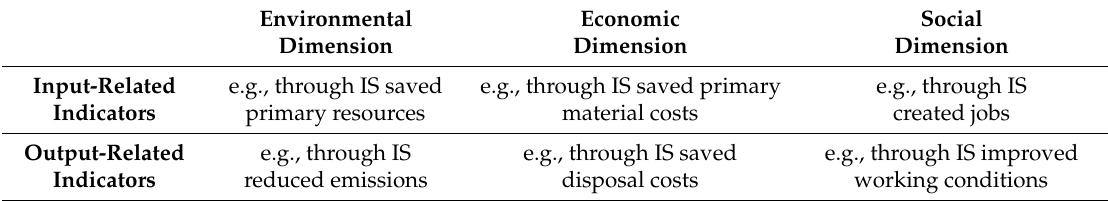
Table 7. Design of the indicator